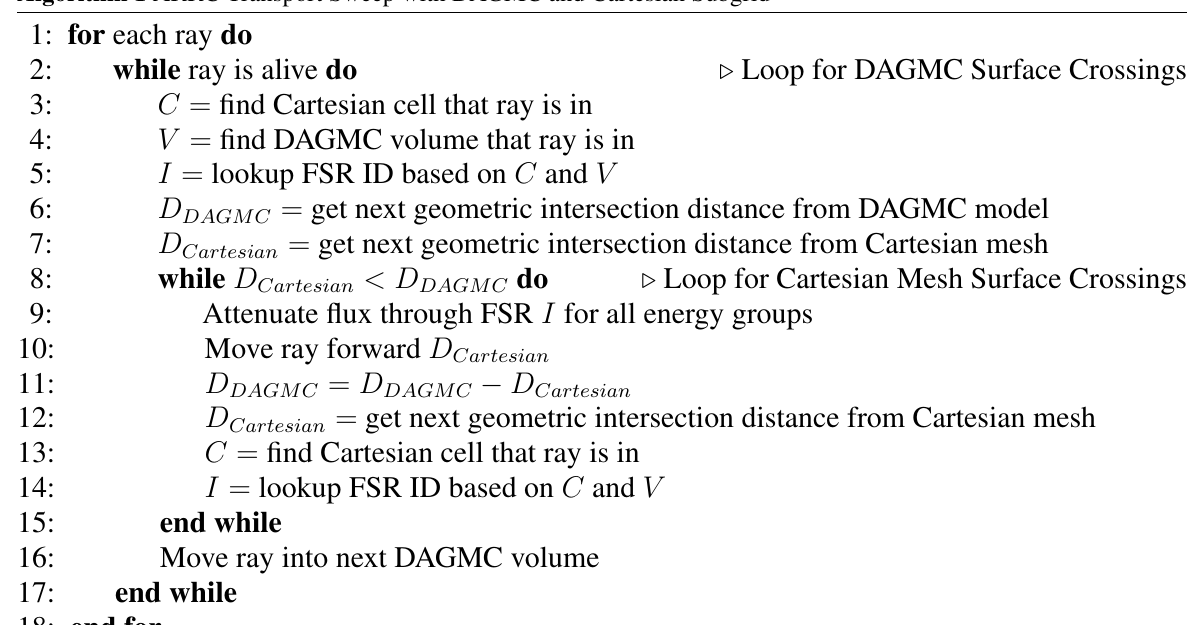
Algorithm 1 ARRC Transport Sweep with DAGMC and Cartesian